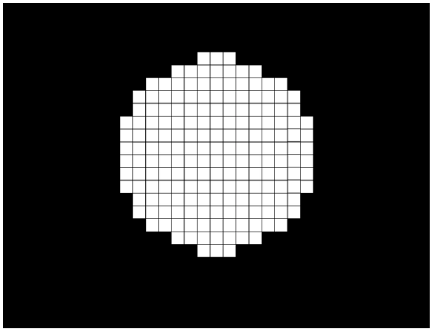
Figure 8. Schematic illustration of a local surface element (white circle). The small squares represent the pixels in the image of the surface segment.